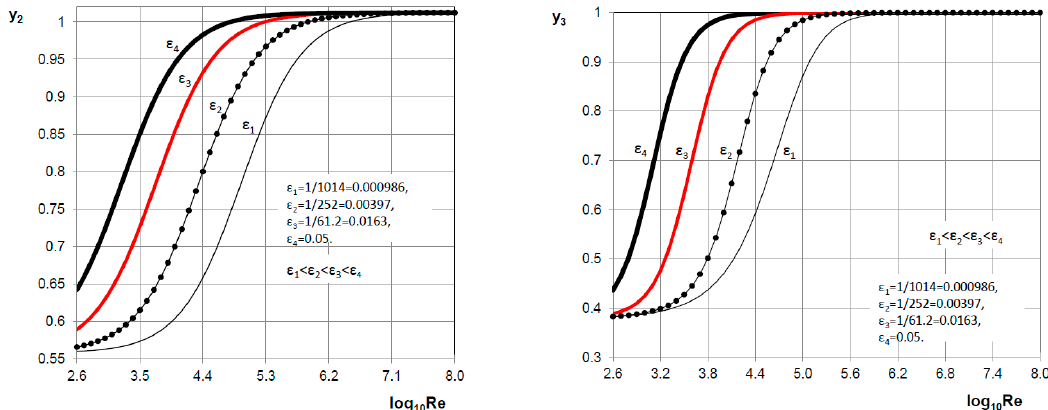
Figure 6. Switching functions y 2 and y 3 , with the main purpose of providing a transition between Figure 6. Switching functions (cid:1877) (cid:2870) and (cid:1877) (cid:2871) , with the main purpose of providing a transition between Figure 6. Switching functions (cid:1877) (cid:2870) and (cid:1877) (cid:2871) , with the main purpose of providing a transition between smooth turbulent flow ( c 1 ) and fully developed rough turbulent flow ( c 3 ) smooth turbulent flow (cid:4666)(cid:1855) (cid:2869) (cid:4667) and fully developed rough turbulent flow (cid:4666)(cid:1855) (cid:2871) (cid:4667) . smooth turbulent flow (cid:4666)(cid:1855) (cid:2869) (cid:4667) and fully developed rough turbulent flow (cid:4666)(cid:1855) (cid:2871) (cid:4667) .